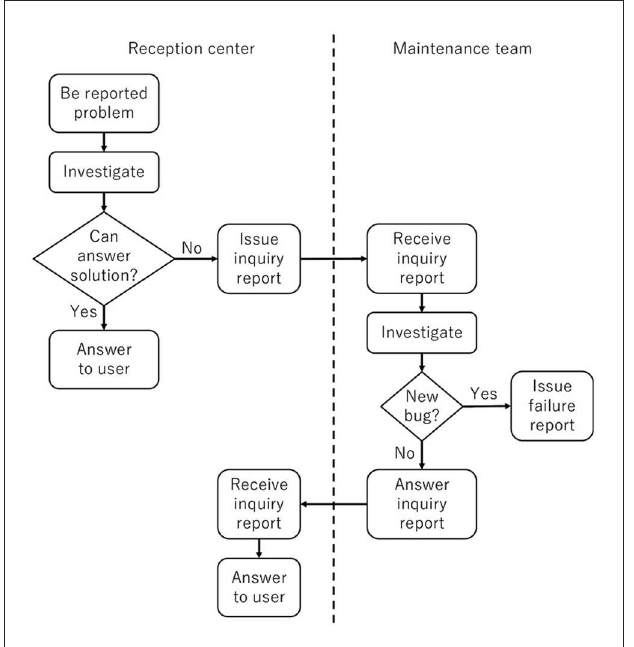
FIGURE2 Maintenance process of the reception center and the maintenance team.